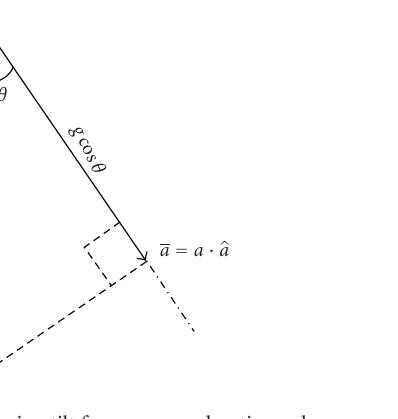
Figure 4: Measuring tilt from one acceleration value.